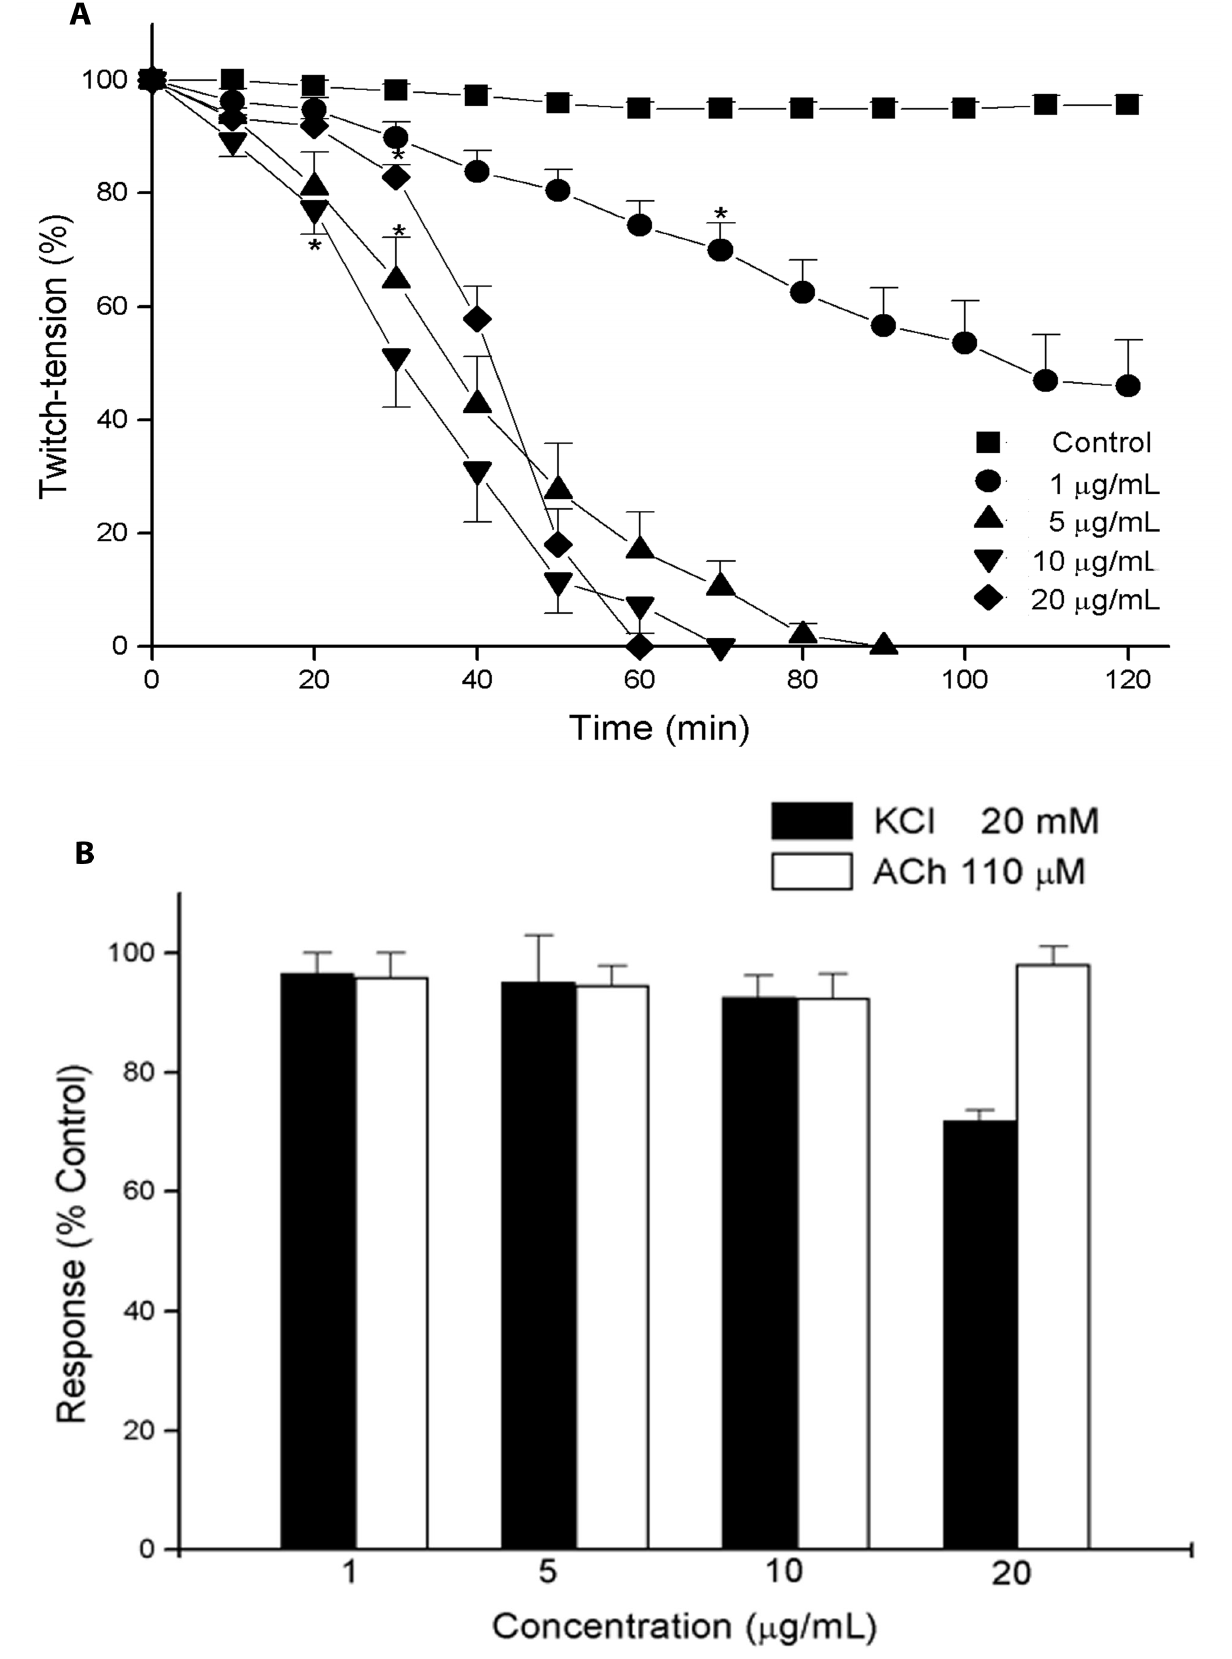
Figure 5. ( A ) Neuromuscular blockade induced by crescent concentrations (1, 5, 10 and 20 µg/mL) of Bmaj- 9 in BC preparation. Note the irreversible twitch-tension neuromuscular blockade for 5, 10 and 20 µg/mL concentrations. ( B ) The graphic represents the effect on contractures to exogenous acetylcholine (ACh) and potassium (KCl). Each point is the mean ± S.E.M. (* p <